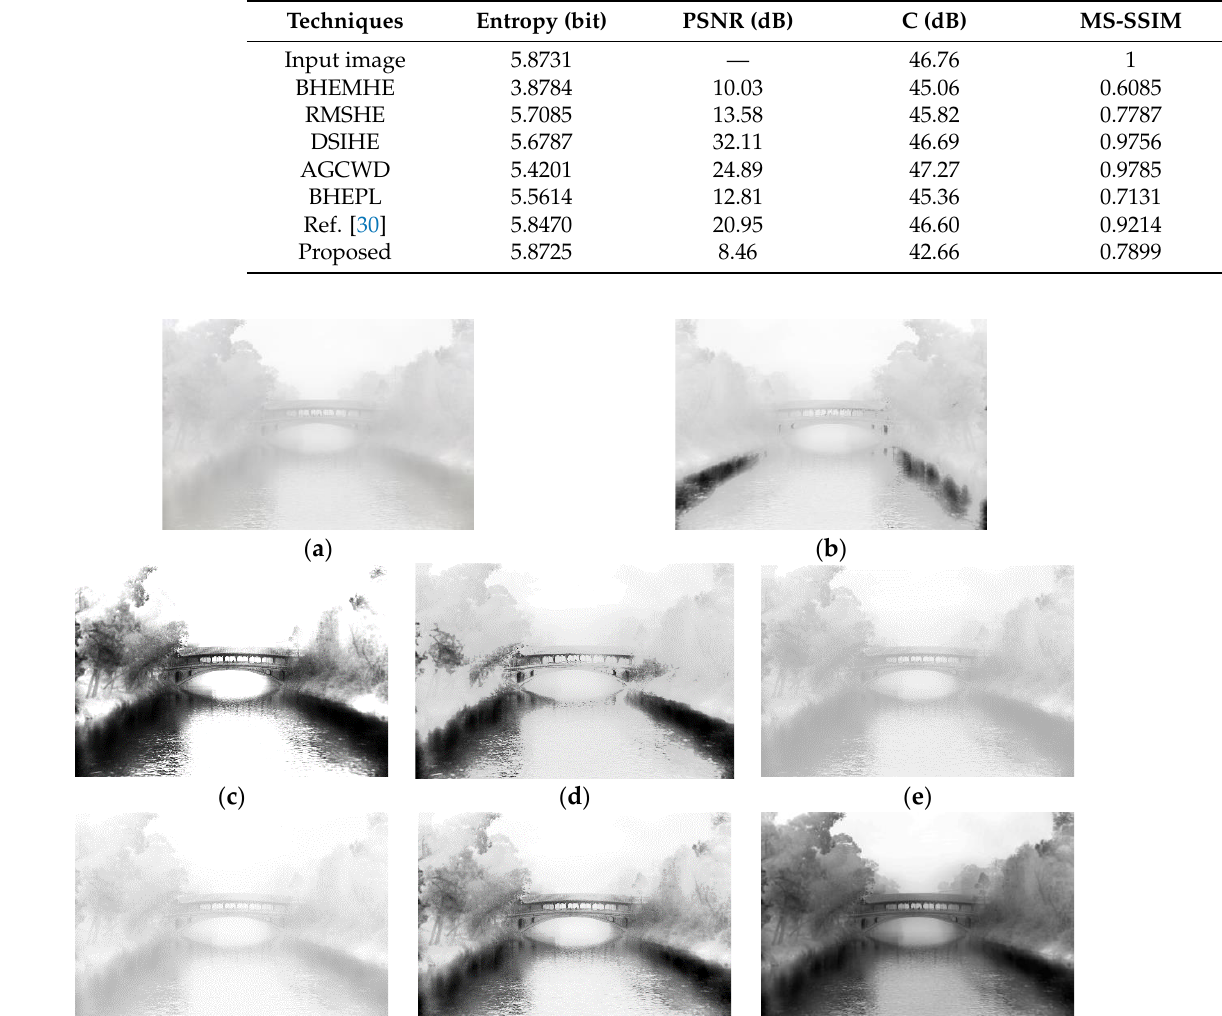
Table 4. Experimental data for the high-grayscale image “bridge”.